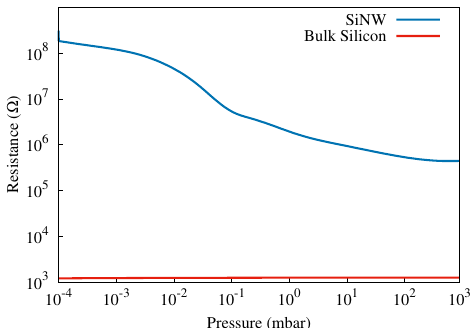
Figure 8. The resistance of sample E (on a log 10 scale) as a function of pressure measured in the vacuum chamber is shown with the blue curve. For comparison, in red, the resistance of a bulk silicon sample (i.e., without